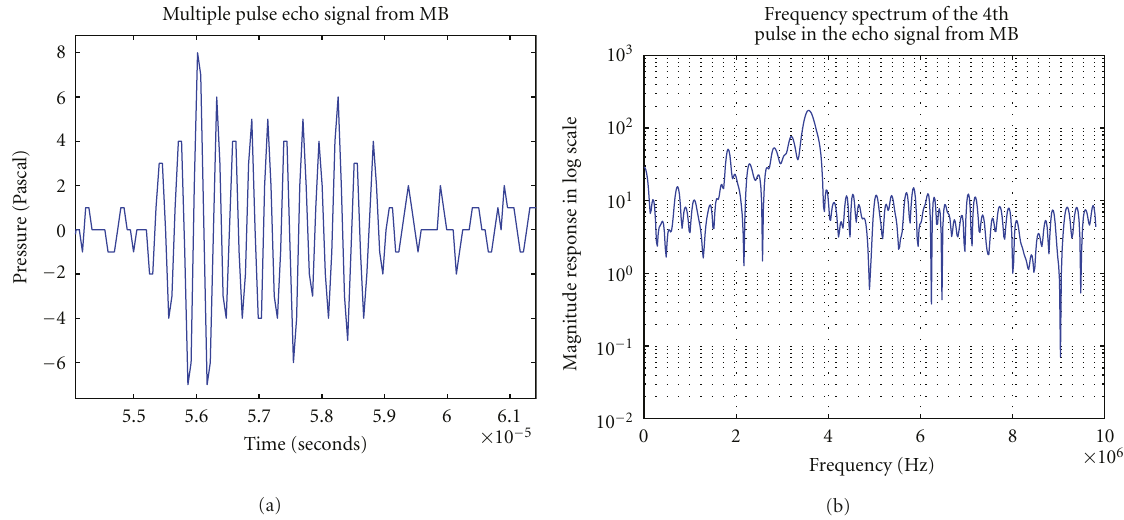
Figure 3: Display the MB echo with transmit frequency at 1.83MHz in the time and the frequency domains. (a) Enlarged version of the 4th pulse in the MB echo. (b) Frequency spectrum of the 4th pulse in the MB